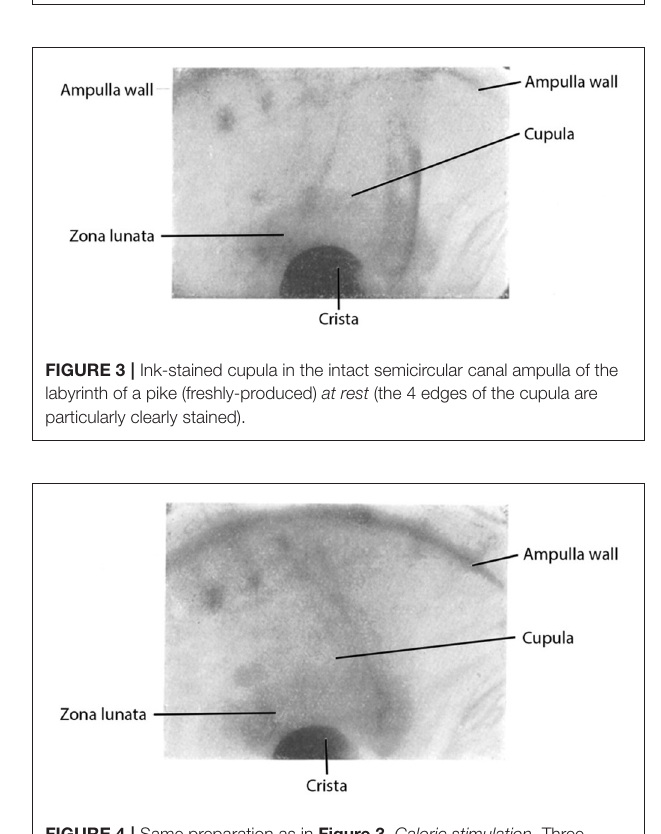
FIGURE 4 | Same preparation as in Figure 3 . Caloric stimulation . Three different deflection positions are photographically superimposed on a stationary plate (see also